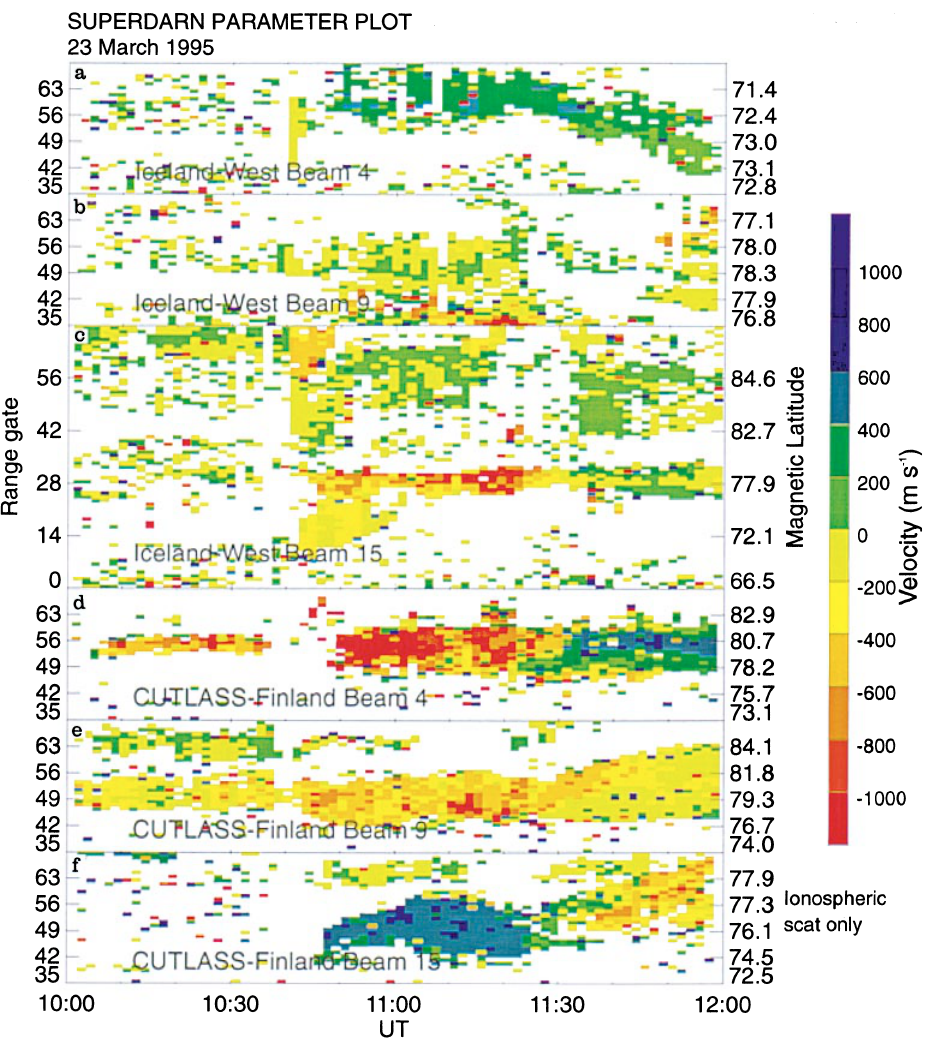
Fig. 5. Range-time-velocity plots of data from beams 4, 9, and 15 of both the Iceland-West and CUT- LASS-Finland radars, the loca- tions of which are shown (at 1100 UT) in Fig. 1. Positive values indicate l-o-s flow towards